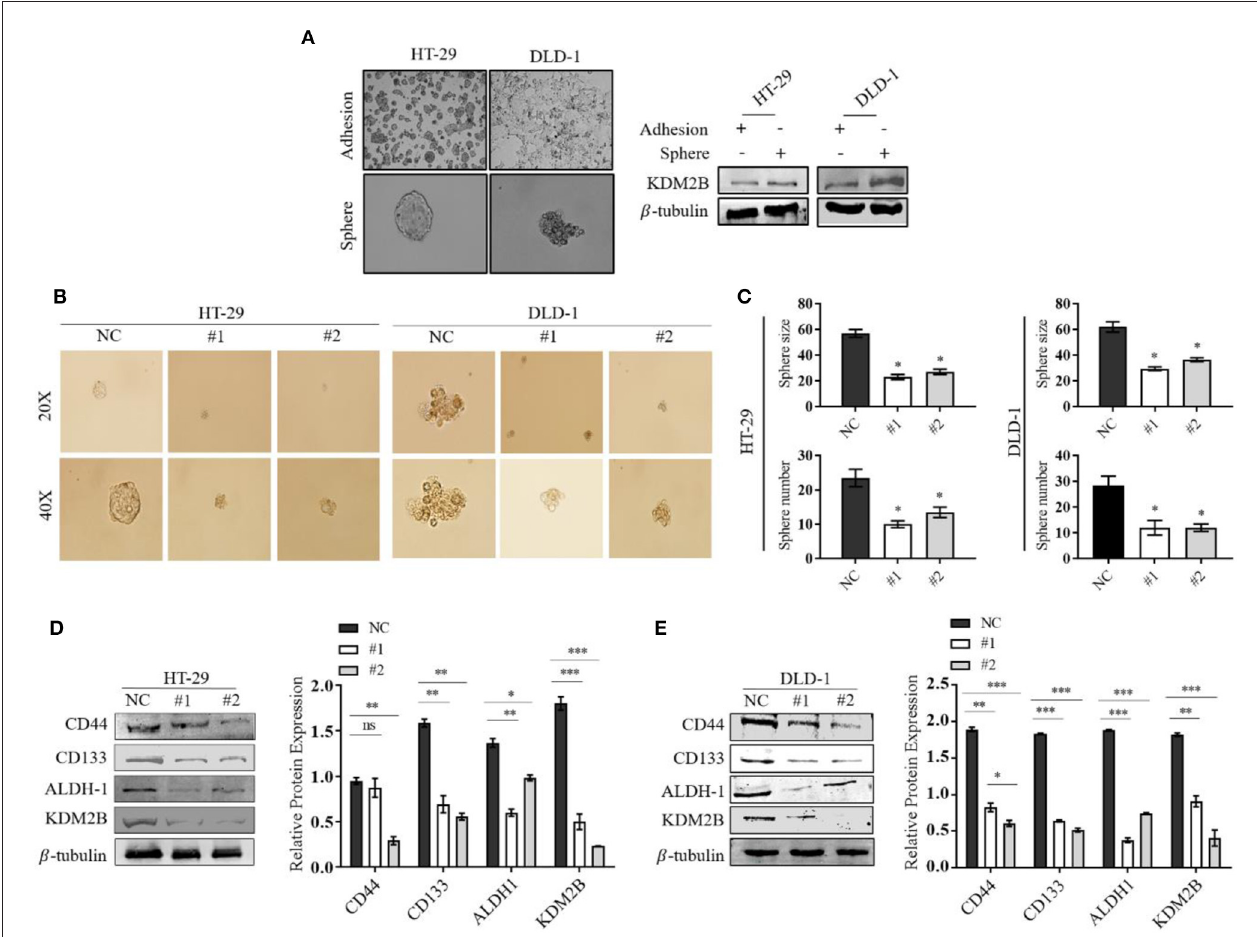
FIGURE 3 | The downregulation of KDM2B regulates the cell stemness in CRC in CRC cell lines. Representative images of adherent cells and the tumor sphere. (A) The assessment of the expression level of KDM2B protein in adherent cells and the tumor sphere was analyzed by Western blotting. (B) Tumor sphere formation of HT-29 and DLD-1 cells. Cells were treated with siKDM2B (#1 and #2) or negative control (NC) for 7 days, and expansion of the tumor spheres were analyzed at 20 × and 40 × magnification under a microscope (bar = 50 µ m; magnification, 200 × and 400 × ). (C) The cluster bar chart of the number and size of spheres formed. (D,E) The effect of KDM2B on CRC cell stem-like markers. CD44, CD133, ALDH-1, and KDM2B levels were analyzed by Western blotting. Data are expressed as Mean ± SEM ( n = 3). * p < 0.05, ** p < 0.01, *** p < 0.001 vs.